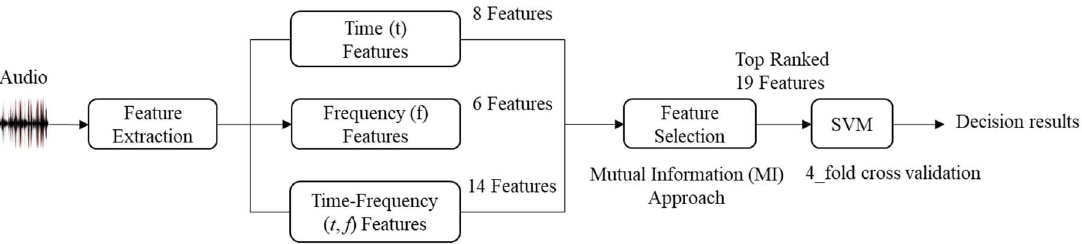
Figure 1. Proposed methodology for detecting acoustic anomalies. The input signal is subdivided into small frames, and features are extracted in the time, frequency, and joint time-frequency domains. The highest ranked features among the computed features are selected.